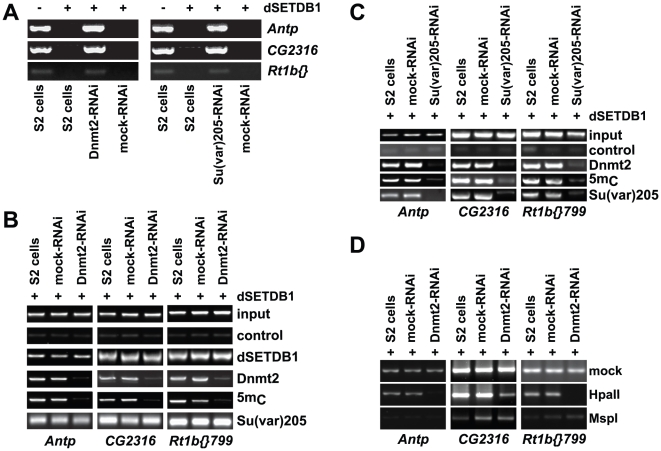
Dnmt2 and Su(var)205 mediate dSETDB1-dependent DNA methylation and silencing of Antp, CG2316 and Rt1b{}799.(A) (Left panel) Digital images of ethidium bromide-stained agarose gels showing reaction products of PCR assays detecting Antp, CG2316, and Rt1b{} transcription in total RNA isolated from S2 cells, S2 cells expressing dSETDB1, and S2 cells transiently expressing dSETDB1 in the presence of small interfering RNA (siRNA) targeting Dnmt2 (Dnmt2-RNAi) or control siRNA targeting human GAPDH (mock-RNAi). (Right panel) PCR assays as in (A) except that S2 cells were treated with siRNA targeting Su(var)205 [Su(var)205 RNAi]. (B) Digital images of ethidium bromide-stained agarose gels detecting the presence of Antp, CG2316, and Rt1b{} in DNA pools generated by ChIP with chromatin isolated from cells described in (A; left panel) Chromatin was immunoprecipitated with the antibodies and controls described in Figure 2C (C) ChIP assays as described in (C) except that chromatin was isolated from cells described in (A; right panel). (D) Digital images of ethidium bromide-stained agarose gels showing the reaction products of methylation-sensitive restriction analyses with genomic DNA isolated from cells described in (A,B). Assays were performed as described (Figure 5D) except that PCR assays detected the presence of Antp, CG2316, and Rt1b{'} in treated DNA pools.